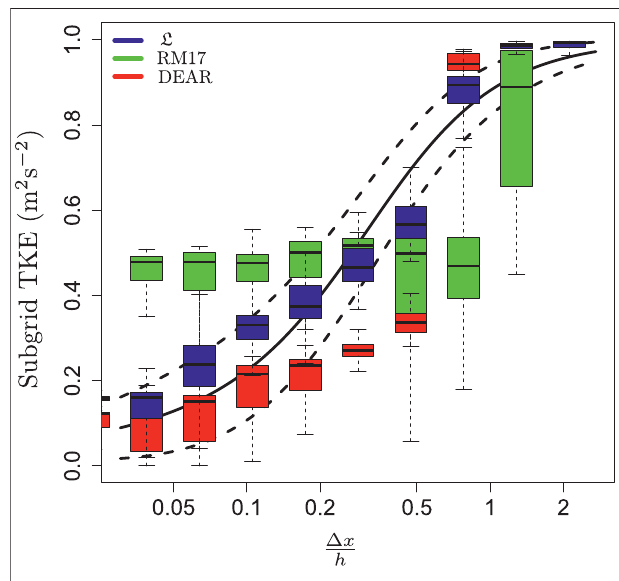
FIGURE 5 | Subgrid TKE as a function of the resolution normalized by the ABL height for IHOP simulationsundertaken withRM17 (in blue), DEAR(in green) or L (in red). The reference partial similarity function for the TKE and the uncertainty margins are represented by the full and dashed black lines, respectively.